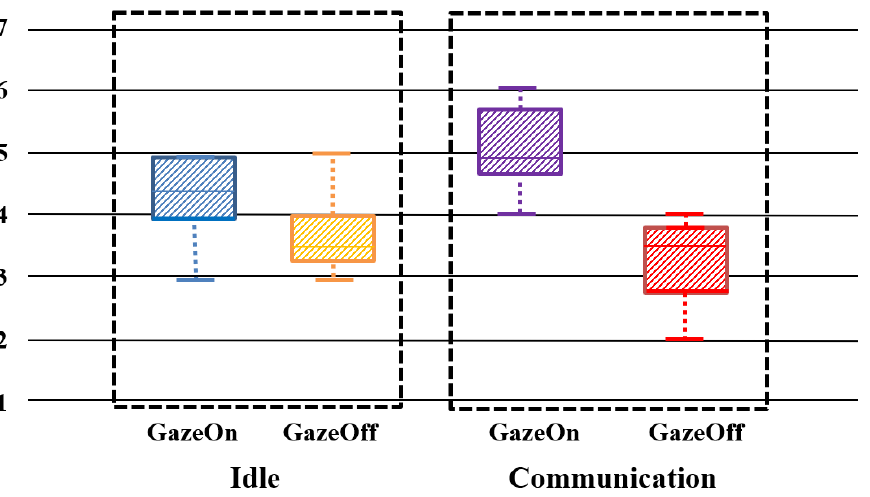
Figure 8. The survey results of user experience: gaze alignment versus without gaze alignment in an idle interaction between the participant and the avatar, and gaze alignment versus without gaze alignment in a communication interaction situation.